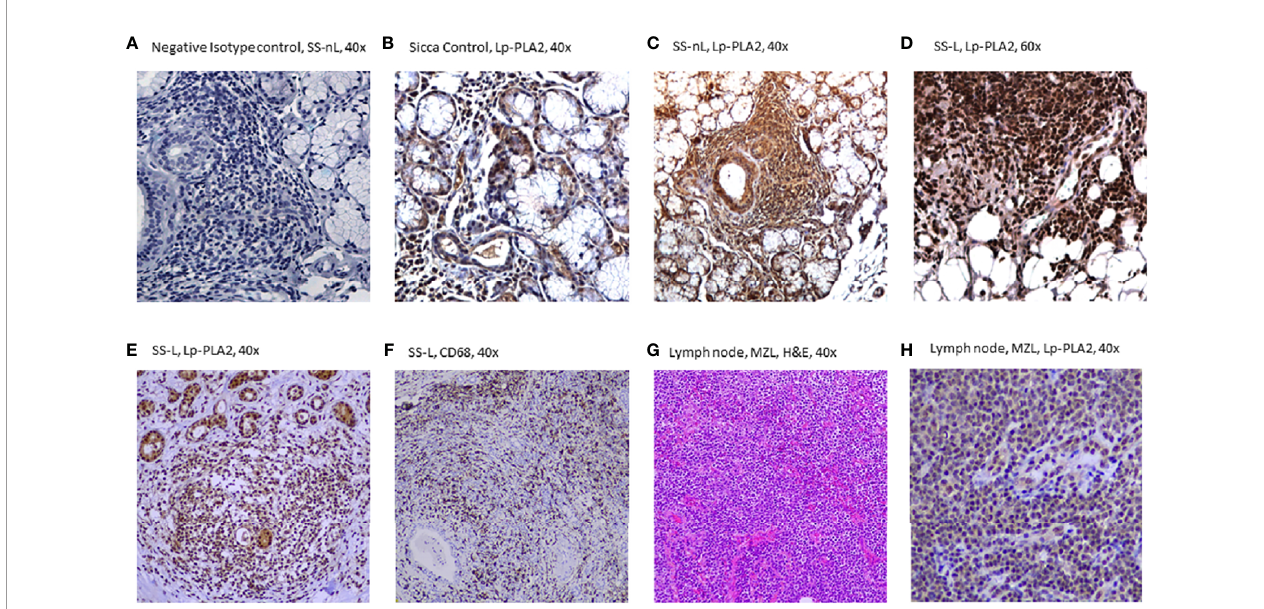
FIGURE 3 | Lp-PLA-2 immunohistochemical expression in minor salivary gland (MSG) tissue sections from patients with sicca features (SC), Sjögren ’ s syndrome with no lymphoma (SS-nL), Sjogren ’ s syndrome with lymphoma (SS-L) (A – F) , as well as in a lymph node derived from a patient with marginal zone lymphoma (G, H) . (A) Isotype Control staining (grade 0), (B) Lp-PLA2 staining in SC (grade 1), (C) Lp-PLA2 staining in SS-nL (grade 2), (D) Lp-PLA2 staining in SS-L (grade 3), (E) Lp-PLA2 in SS-L, (F) CD68 staining (denoting the presence of tissue macrophages) in SS-L (same patient as E ), (G) Hematoxylin & Eosin (H&E staining), marginal zone lymphoma (MZL), (H) Lp-PLA2 in a lymph node from a non-SS patient with MZL (same patient as G